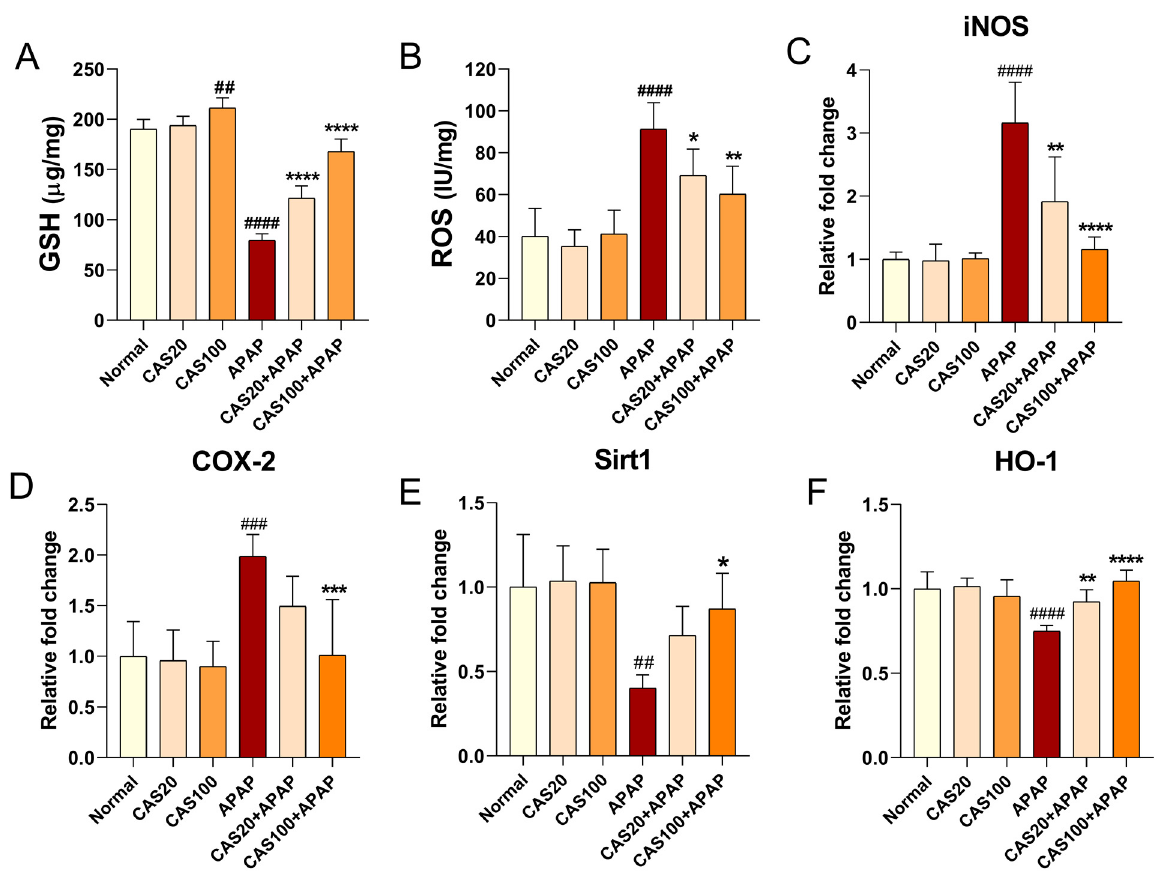
Figure 5. Hepatic antioxidant effect of CAS against APAP-induced oxidative stress in mice via modulating Sirt1/HO-1 mRNA expression. ( A ) The hepatic GSH content in the liver tissues of each group ( n = 6). ( B ) The ROS level in the liver tissues of each group ( n = 6). ( C – F ) RT-qPCR results of antioxidant-related mRNA expression ( iNOS, COX-2, Sirt1 , and HO-1 ) in the liver tissues of mice after CAS and APAP administration ( n = 6). The data are expressed as the mean ± SEM and were analyzed via one-way ANOVA with Tukey’s post-hoc test. Significant differences are indicated as follows: ## p < 0.01, ### p < 0.001, and #### p < 0.0001 vs. blank group; * p < 0.05, ** p < 0.01, *** p < 0.001, and **** p < 0.0001 vs. APAP group.